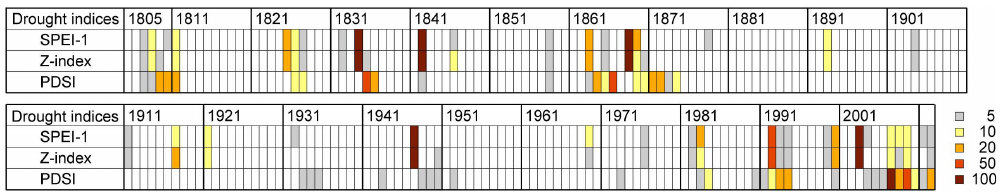
Fig. 5. Droughts expressed by SPEI-1, Z-index and PDSI for April–September with their recurrence interval N ≥ 5yr in the Czech Lands during the 1805–2012 period.